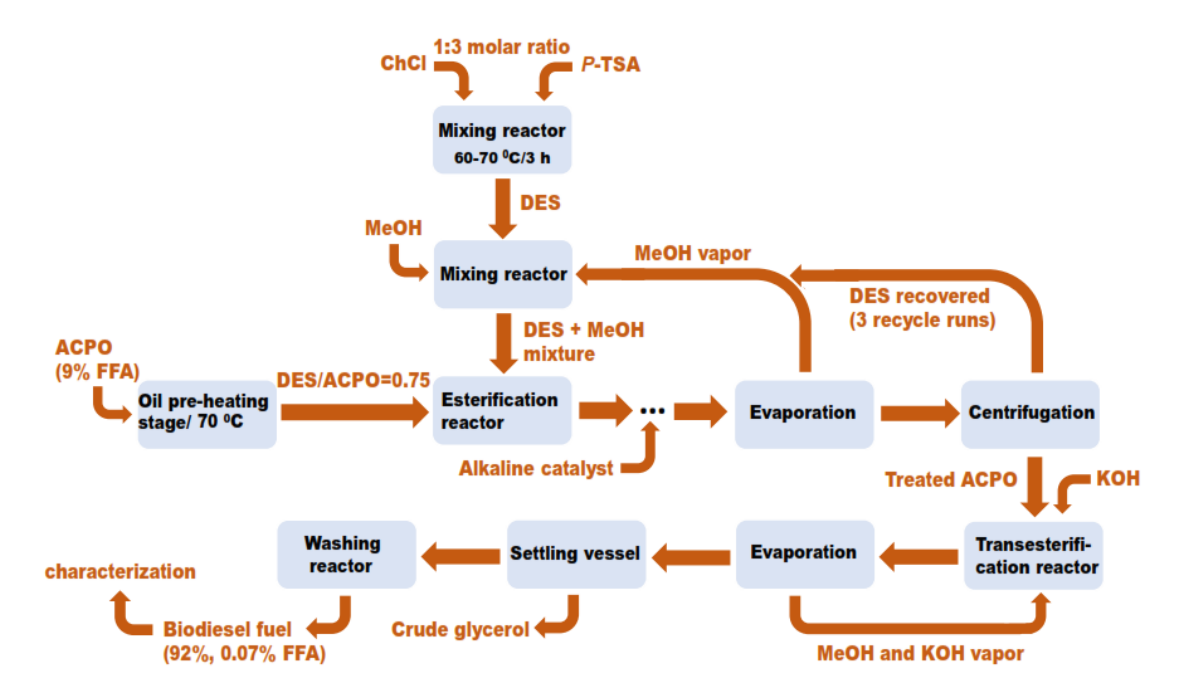
Figure 7. The flowchart for production of biodiesel from acidic crude palm oil (ACPO). Alhassan et al. [64] used the biomass-derived Pongamia pinnata seed oil and (ChCl:4 p - TSA) DES to produce biodiesel in a single step. The DES was used with and without silica